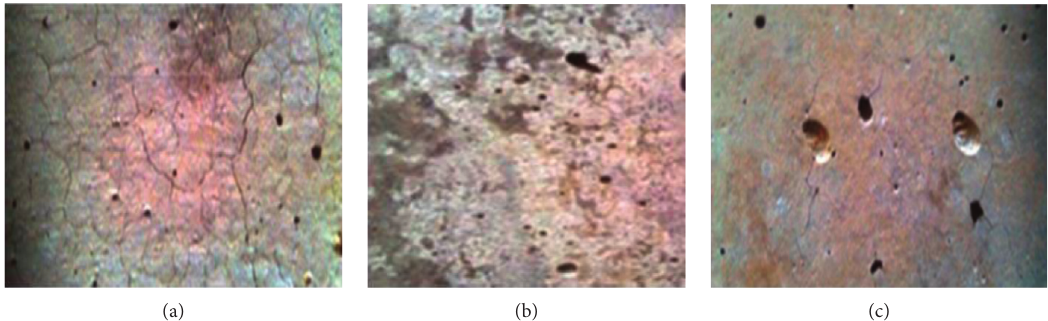
Figure 8: Concrete appearance changes at 600 ° C: (a) control sample, (b) sample containing 2% Al containing 2% GO/Al 2 O 3